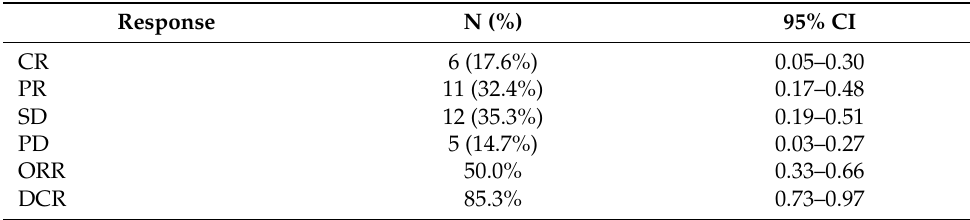
Table 2. BNCT treatment response (N = 34).